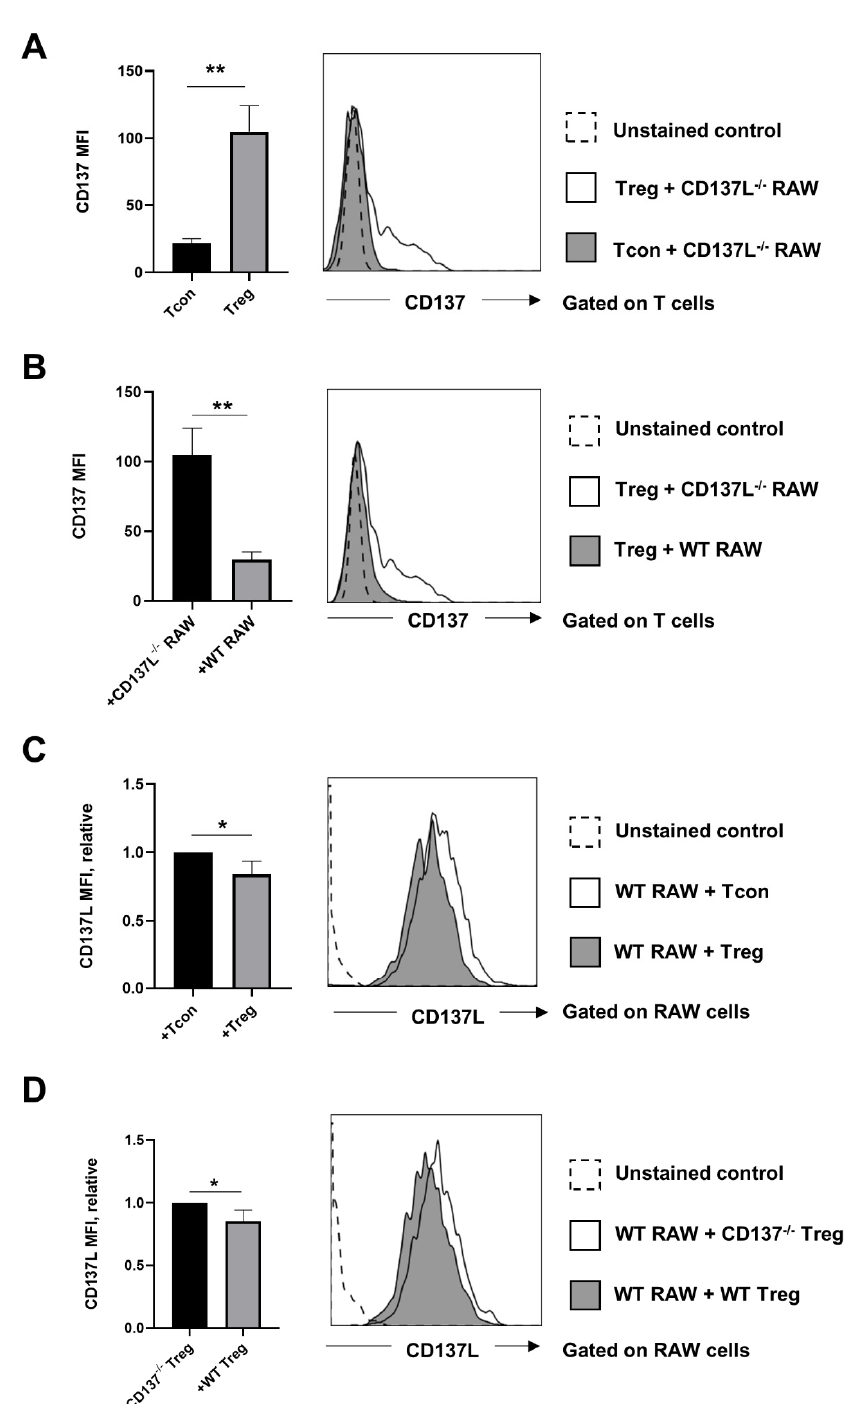
Figure 1. Transfer of CD137 and CD137 ligand (CD137L) between murine regulatory T cells (Treg) and antigen presenting cells (APC). Results were obtained after 1 h of coculture at a 1:1 ratio. ( A ) CD137L-deficient (CD137L − / − ) RAW cells were cocultured with either wild-type (WT) conventional T cells (Tcon) or WT Treg. Graph shows mean fluorescence intensity (MFI) of CD137 on Tregs and Tcons, after the coculture. ( B ) WT Treg were cocultured with WT RAW264.7 or CD137L − / − RAW cells. Graph shows MFI of CD137 on Tregs, after the coculture. ( C ) WT RAW264.7 cells were cocultured with WT Tcon or WT Treg. Graph shows relative CD137L MFI on WT RAW 264.7 cells after the coculture. ( D ) WT RAW264.7 cells were cocultured with WT Treg or CD137-deficient (CD137 − / − ) Treg. Graph shows relative CD137L MFI on WT RAW 264.7 cells after the coculture. All graphs show means ± SD, * p < 0.05, ** p < 0.01, two-tailed unpaired Student’s t test. Data are representative of three independent